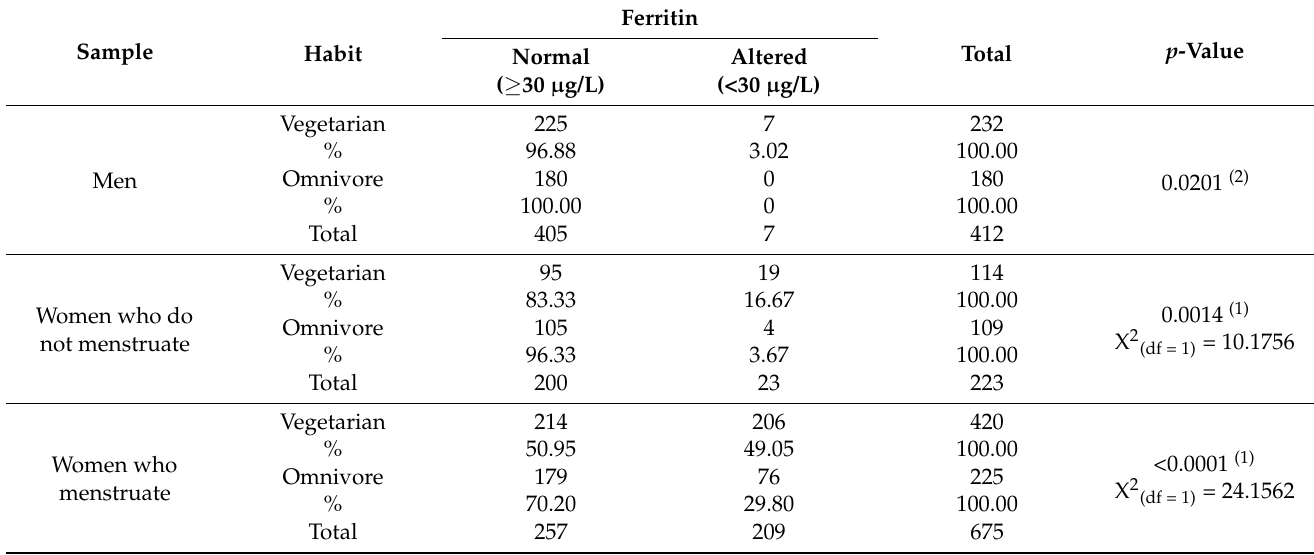
Table 3. Overall sample: diagnosis of iron deficiency among men and women who do not menstruate and menstruate based on eating